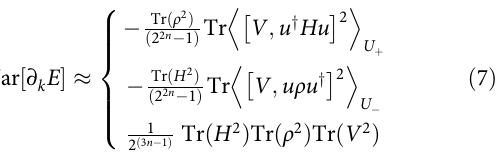
(cid:5) (cid:6) gates applied to all 4